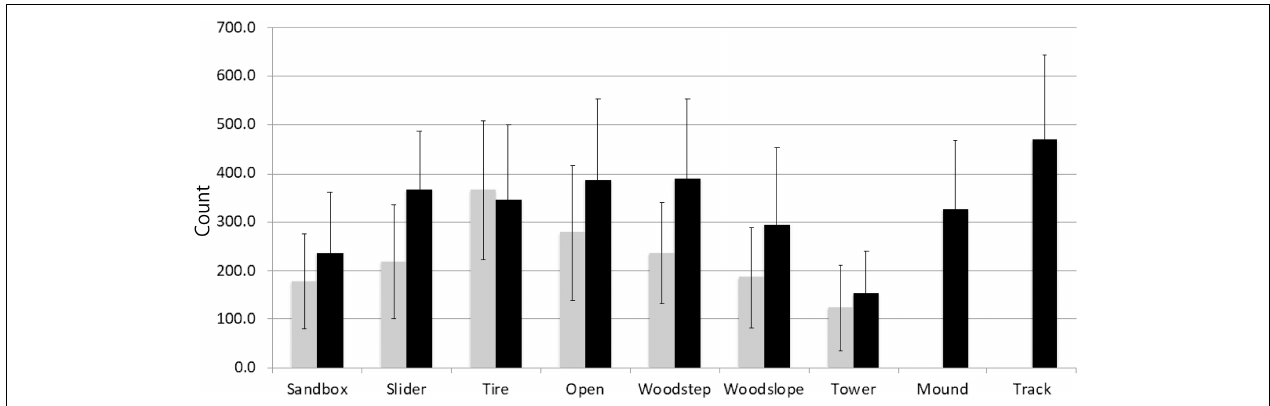
FIGURE 4 | The averaged accelerometer counts per epoch before and after the alteration. The data for mound and track areas were not available before the alteration.